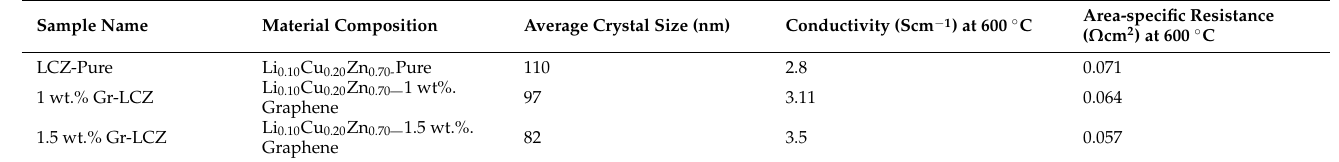
Table 1. Crystallite size, conductivity, and area-specific resistance (ASR) of prepared cathode